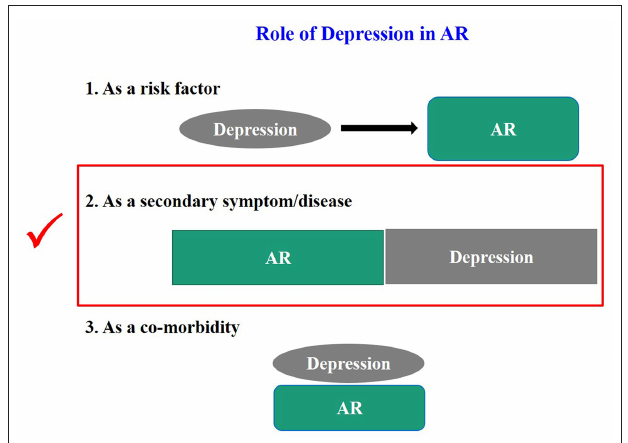
FIGURE 1 | Schematic diagram of the relationship between depression and